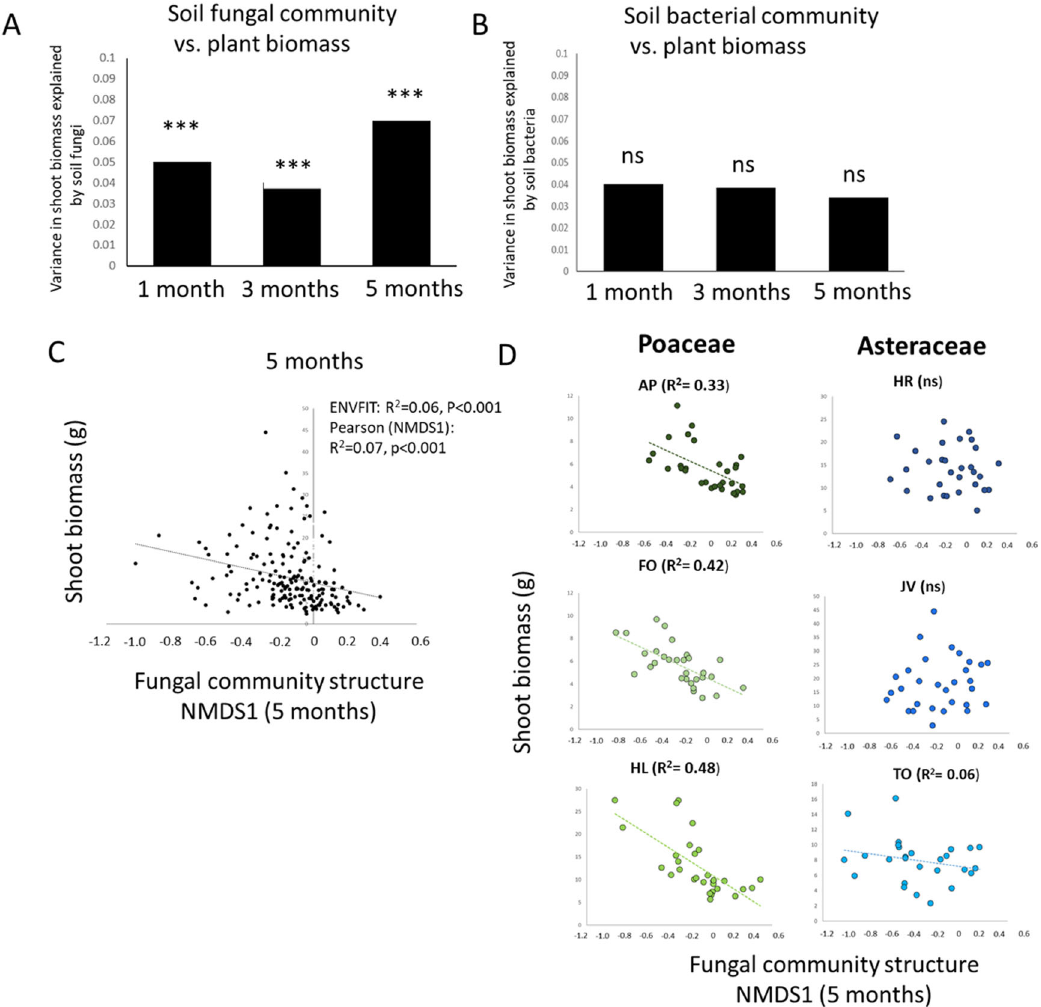
Fig. 5 The soil microbial community explaining plant growth. The variance in plant shoot biomass (dw) explained by soil fungal ( A ) and bacterial ( B ) community composition at different time points. The statistical results given in panels A and B are PERMANOVAs on Bray-Curtis distances and based on full data. C Relationship between shoot biomass and fungal community structure measured by fi rst dimension of community structure NMDS1 (Pearson correlation) and by using all the data and full model (ENVFIT; see text), and D divided per current plant species. In D correlation coef fi cients are shown only for plant species signi fi cantly responding to changes in the soil fungal